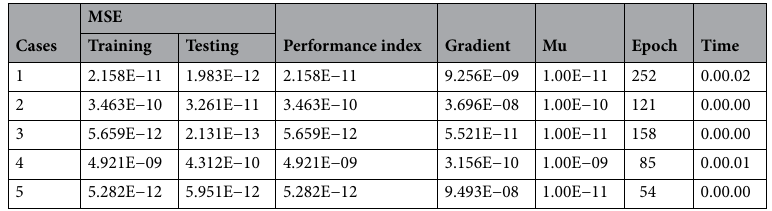
Table 8. Scenario 6: variation of Q